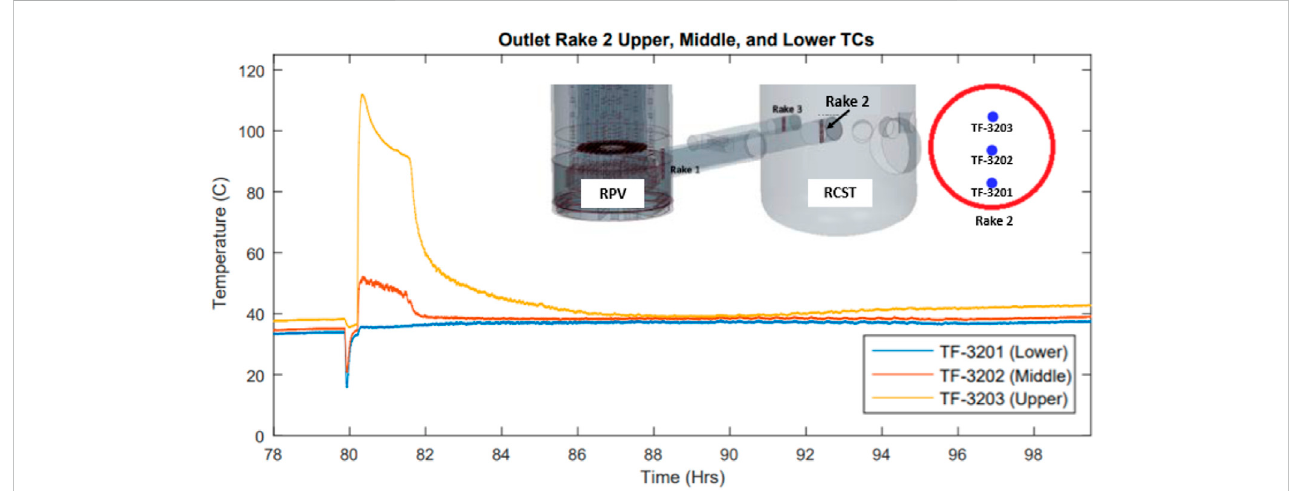
FIGURE 3 Hot leg ’ s Rake 2 thermocouples readings starting in the 78th hour of the PG-29 test (Woods, 2019).